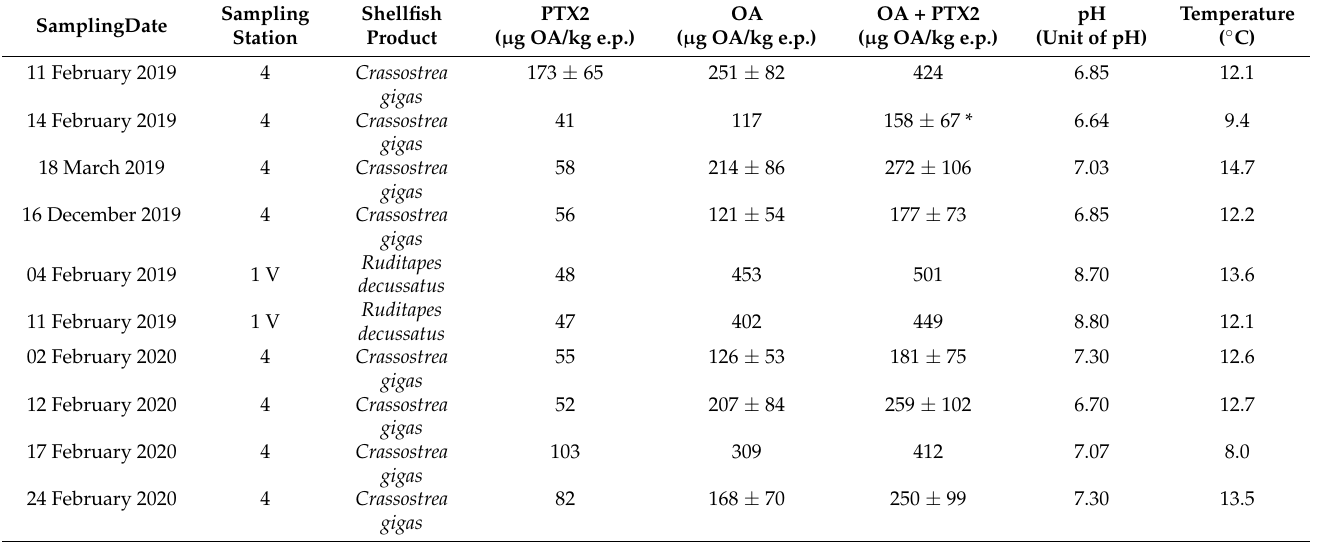
Table 5. Values of PTX, OA and parameters of water in samples with concurrent presence of PTX2 and OA.